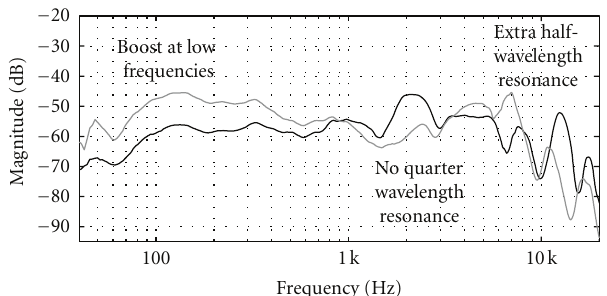
Figure 6: A generic equalization curve measured from the ARA mixer